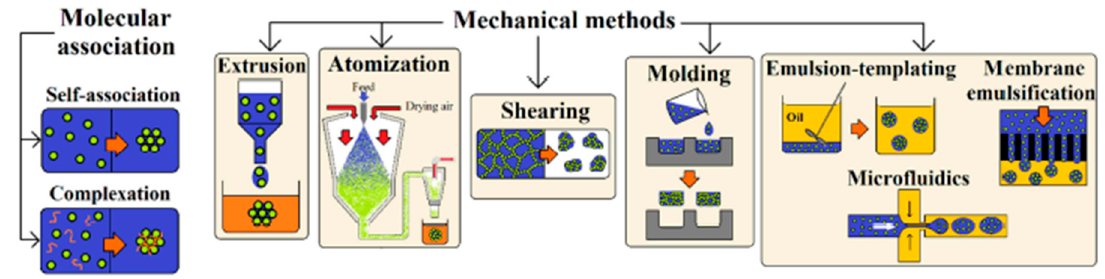
Figure 8. Scheme showing the different preparation methods applied for the production of micro/nanogel particles. Reproduced with permission from [147], copyright 2017